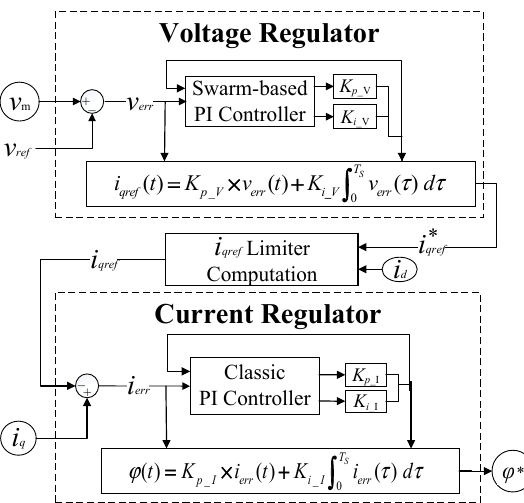
Figure 15. STATCOM voltage and current regulators with swarm-based PI controller.